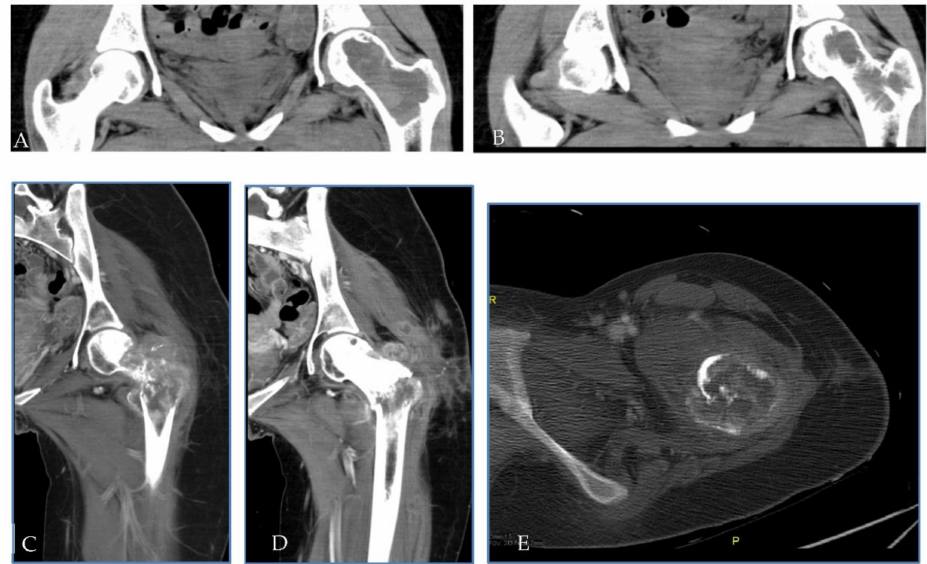
Figure 7. ( A , B ) At time of diagnosis, CT scan showed a well-defined osteolytic lesion of the head and neck of the left femur with integrity of cortical bone. ( C – E ) During the follow up, for the occurrence of a pathological fracture, CT scan showed a large, complex area of osteostructural alteration of the neck and femoral shaft composed of solid vascularised tissue widely extended in perifemural